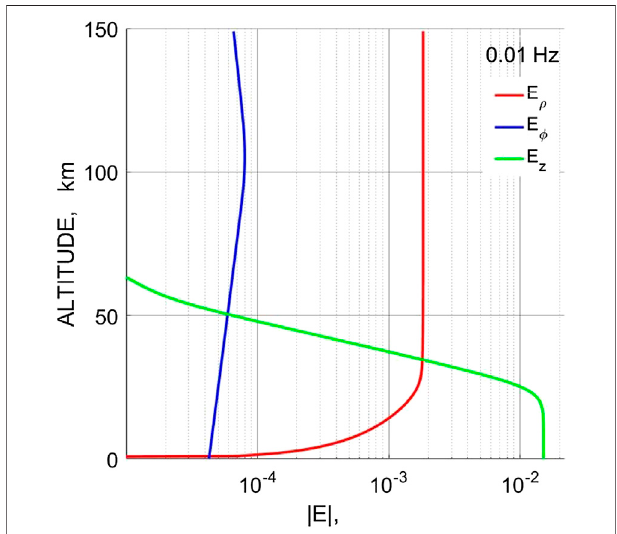
FIGURE8 | The altitudinalstructure ofall three electric fi eldcomponents E ρ ( z ), E ϕ ( z ), and E z ( z ) (in V/m).